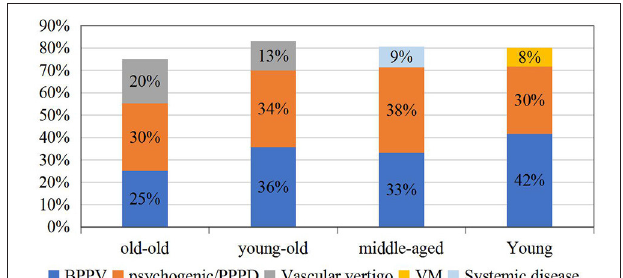
FIGURE 3 | The etiologic distribution of dizziness/vertigo by the age group during the coronavirus disease 2019 (COVID-19)